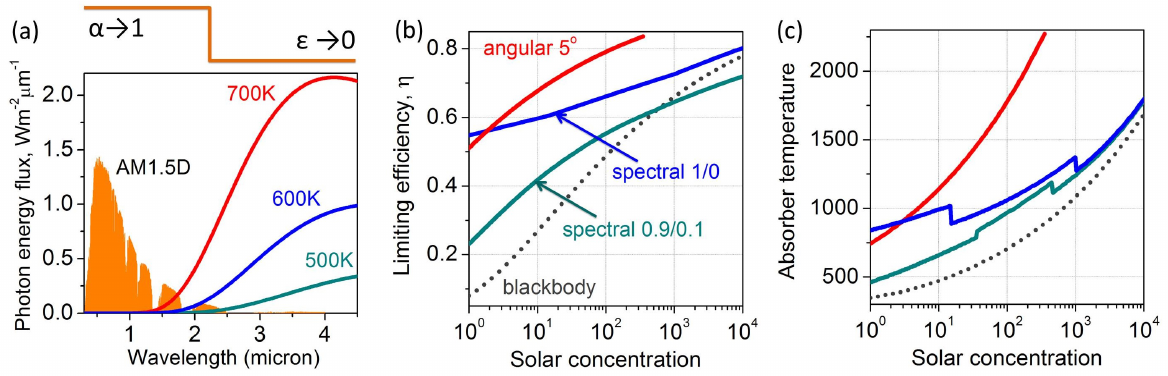
Fig. 4. The role of spectral and angular selectivity in solar thermal energy conversion. (a) Frequency spectra of terrestrial solar radiation (AM1.5D, orange) and of thermal radiation of blackbody emitters at varying temperatures. The top inset shows the ideal spectral absorp- tance/emittance characteristics of the solar receiver surface. (b) The limiting eflciency of solar thermal energy converters with a blackbody (gray dotted line) and selective (solid lines) absorbers as a function of solar concentration. The engines are assumed to convert thermal energy at the Carnot eflciency. For spectrally selective absorbers, the transition frequency between high and low emittance levels (labeled as ratios α / ε ) is optimized for each concentration ratio. Angularly selective absorber has no spectral selectivity (1/1), yet is only able to absorb and emit photons in the narrow angular range of +/− 5 degrees from normal. (c) The corresponding equilibrium temperature of the absorbers with the optimized transition point between high and low emittance levels discussed in (b) as a function of solar